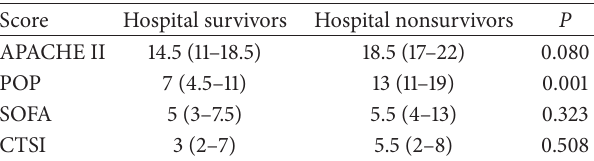
Table 2: Average scores of patients who survived and those who died in hospital.